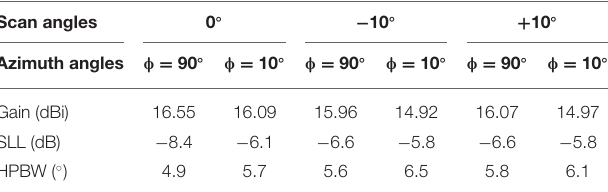
TABLE 2 | Details of the electrical performance of the reflectarray for several scan angles. Scan angles 0 ◦ − 10